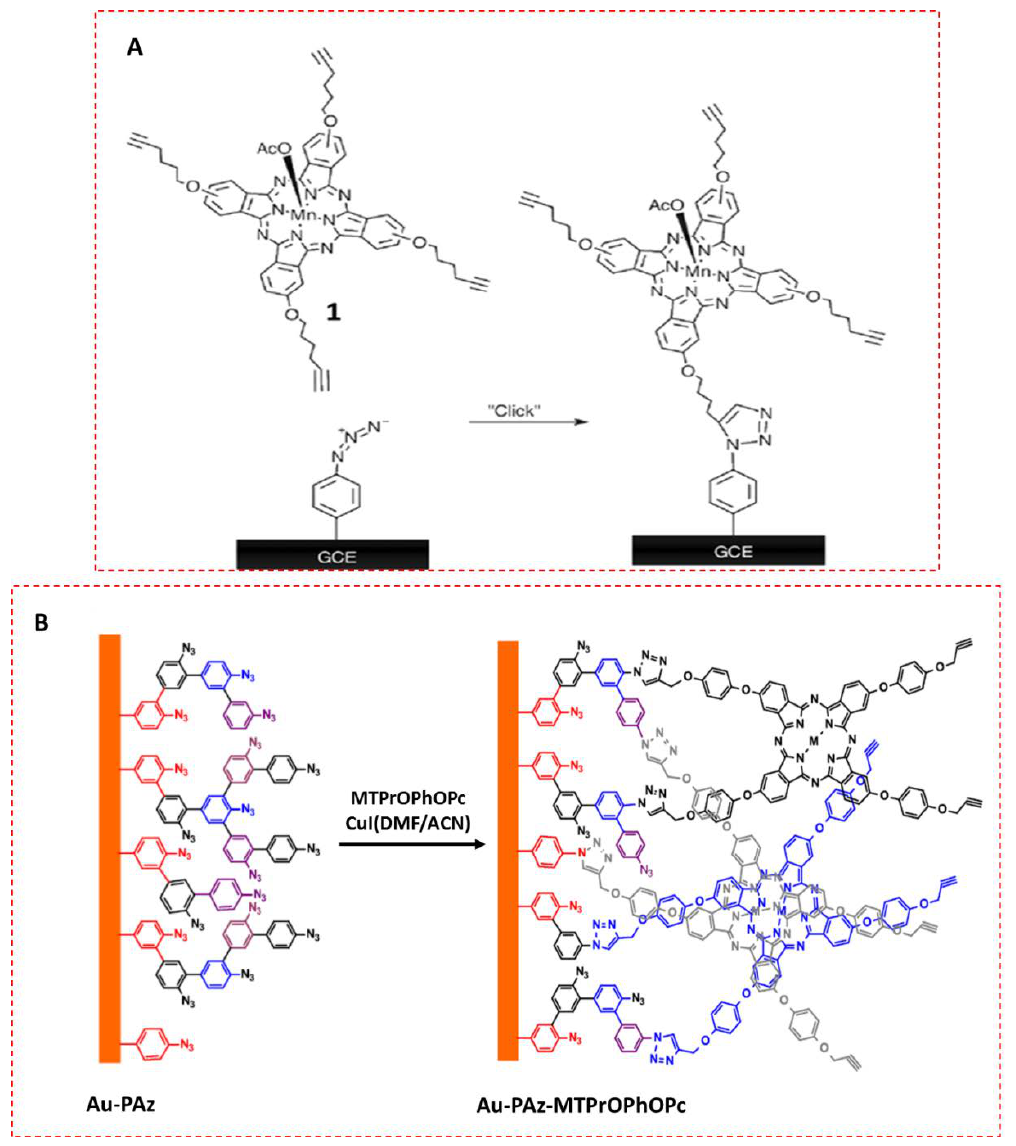
Figure 4. Clicking of (OAc)Mn tetrakis(5-hexyn-oxy) phtalocyanine to a grafted GCE (OAc: acetate) ( A ). Scheme of electrochemical grafting and click reaction of MTPrOPhOPcs onto grafted AuE ( B ). Reprinted from [32] ( A ) and [34] ( B ).